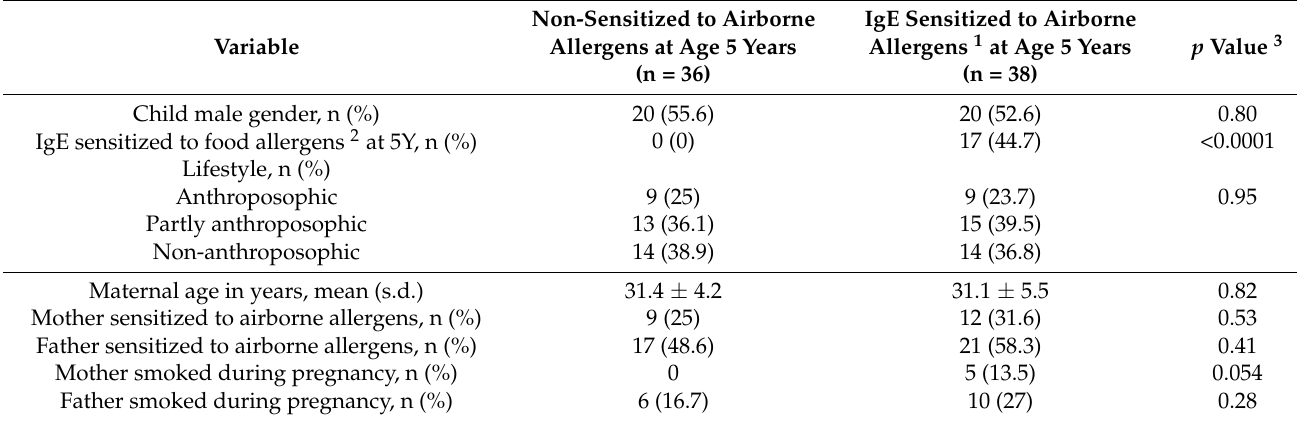
Table 1. Demographic data of parent–child pairs included in this